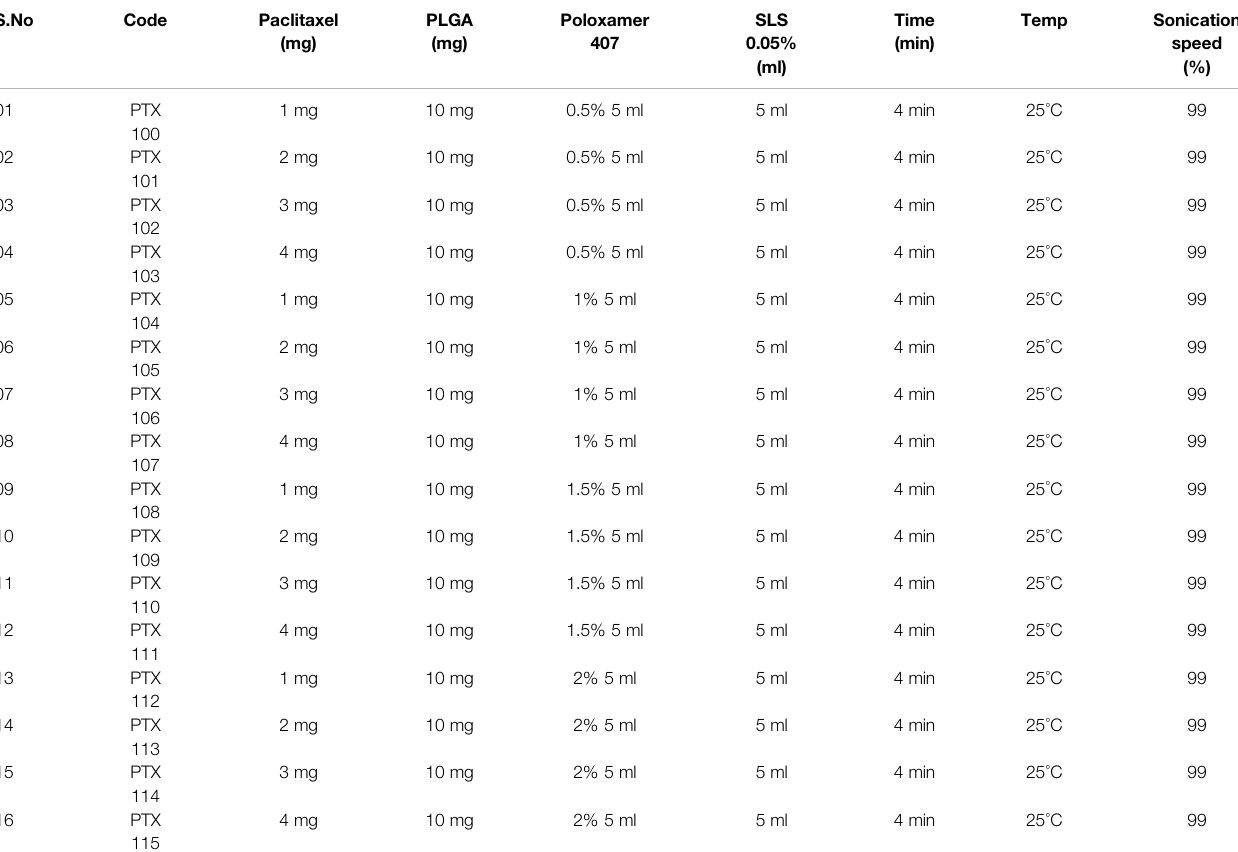
TABLE 1 | Formulation of paclitaxel with PLGA, 0.05% SLS, and 0.5, 1, 1.5, and 2% poloxamer 407.